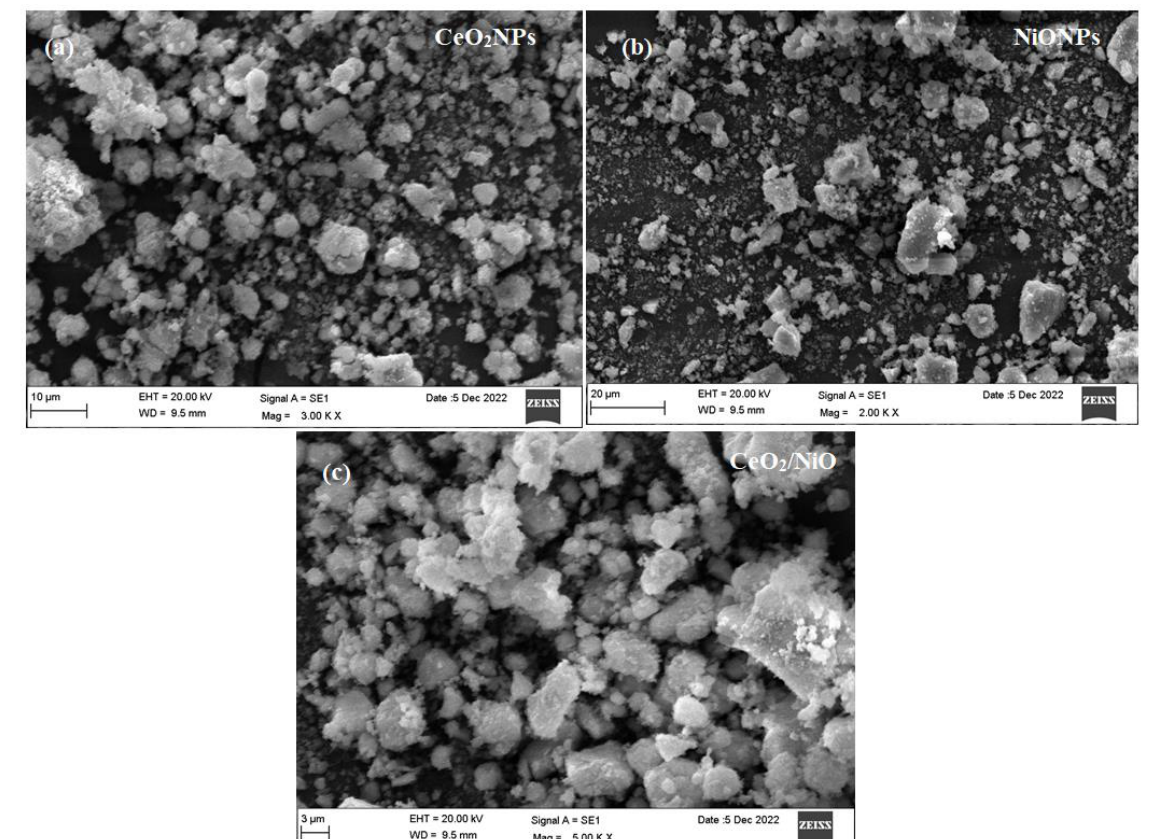
Figure 4. SEM images of ( a ) CeO 2 NPs ( wheat husk extract), ( b ) NiONPs (rice husk extract) and ( c ) their CeO 2 /NiO nanocomposite, respectively.